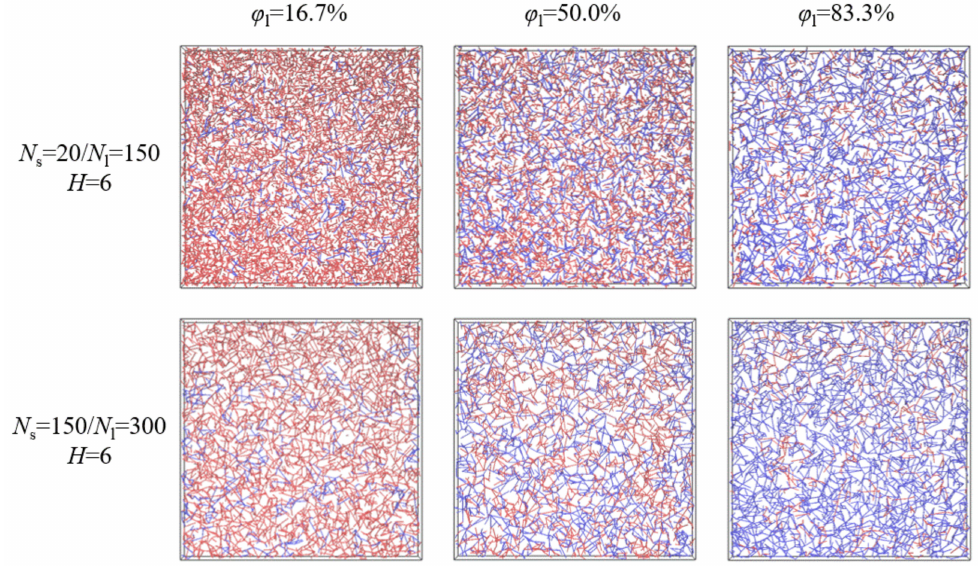
Figure 1. Representative primitive path networks with the shorter ( red ) and longer ( blue ) chains for polymer films of N s = 20/ N l = 150 and N s = 150/ N l = 300, where the film thickness is fixed as H = 6 and the weight fraction of the longer chains is changed from ϕ l = 16.7% to ϕ l = 83.3%.